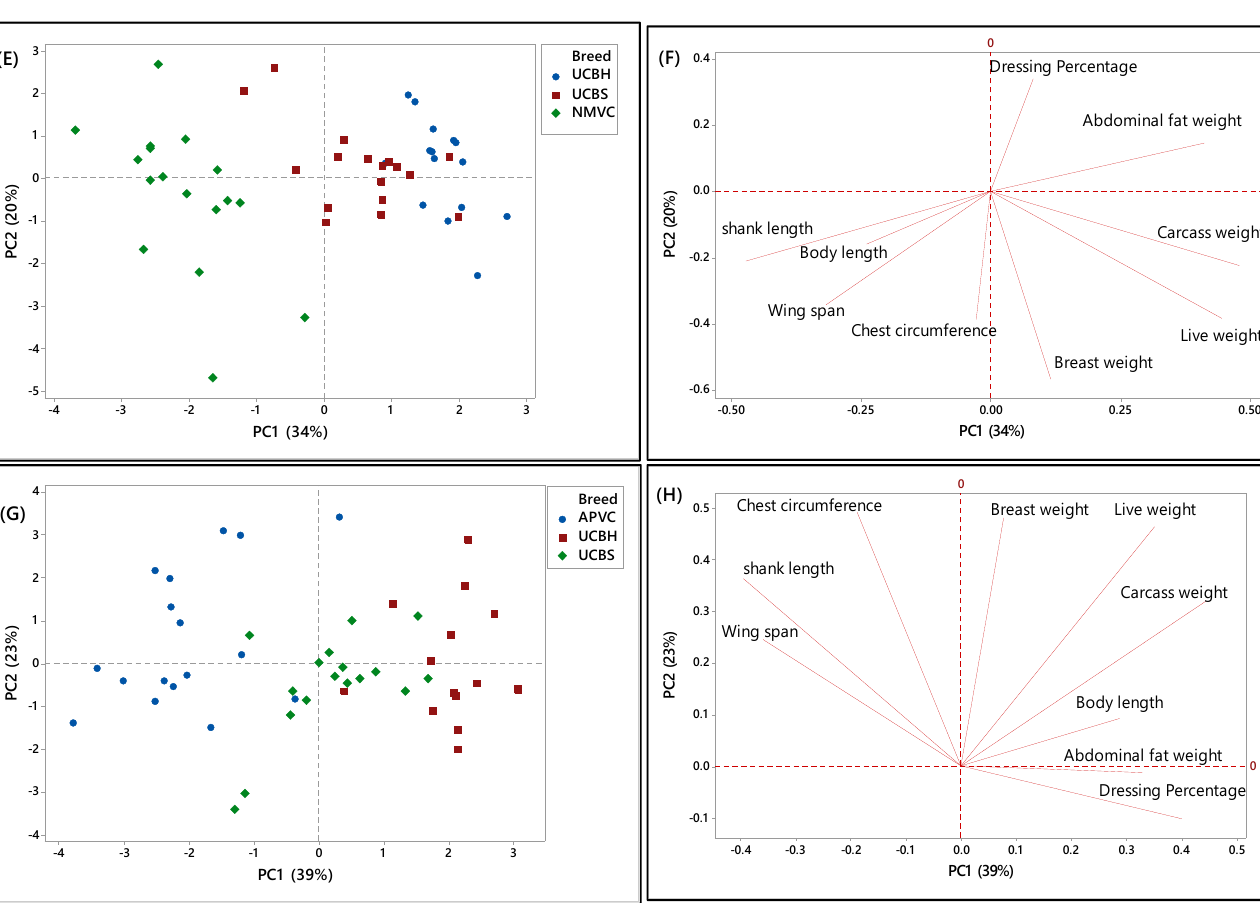
Figure 3. PCA score and loading plots showing the clustering pattern of different chicken breeds based on the nine phenotypic characteristics. ( A , B ) Score and loading plots of all breeds studied in the second phase, ( C , D ) naturally and selective mated village chickens (NMVC, APVC), ( E , F ) naturally mated village chicken (Ayam Kampung) (NMVC) and underaged colored broilers (UCBH, UCBS), and ( G , H ) selective mated village chicken-Akar Putra (APVC) and underaged colored broilers (UCBH, UCBS).